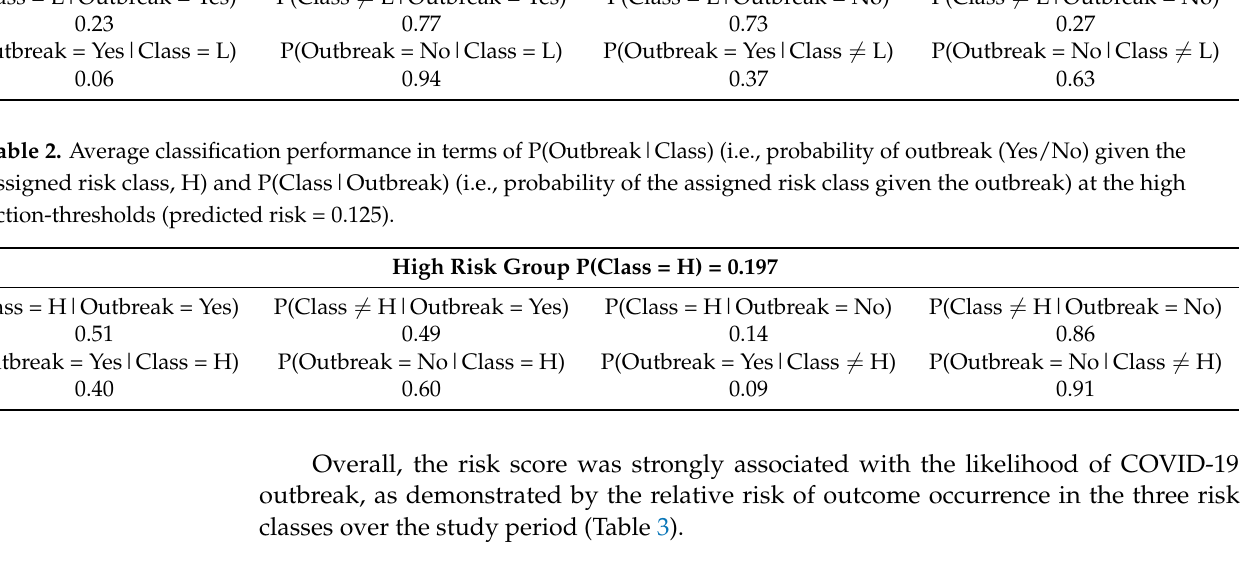
Table 3. Average classification performance in terms of relative risk of COVID-19 outbreak by